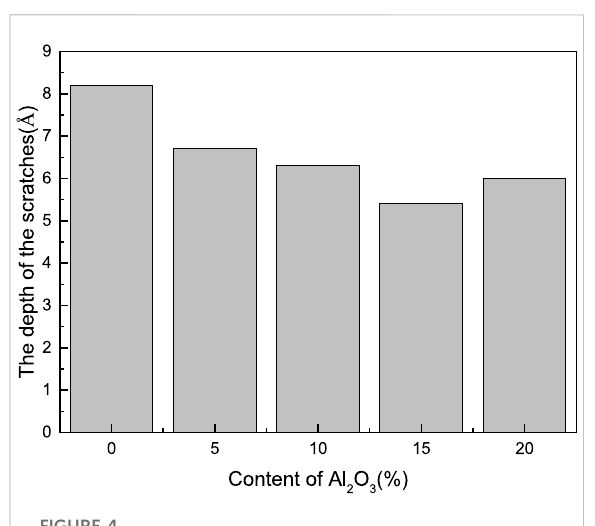
FIGURE 4 The curveofcontentofAl 2 O 3 and thedepth ofthescratches.